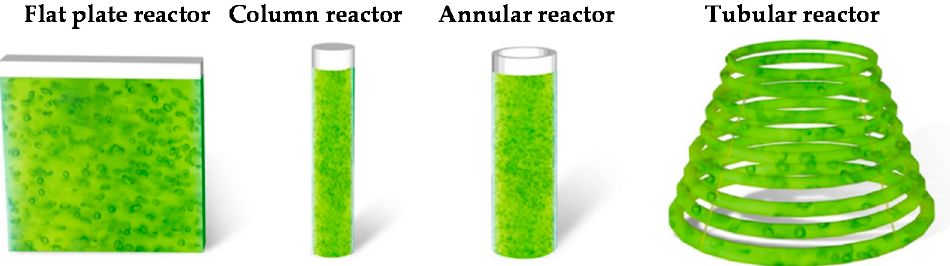
Figure 2. Schematic representation of close cultivation systems of microalgal cultivation .